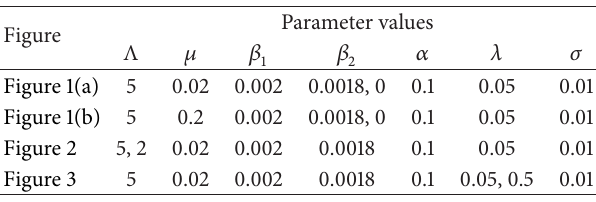
Table 1: Parameters for the simulation.